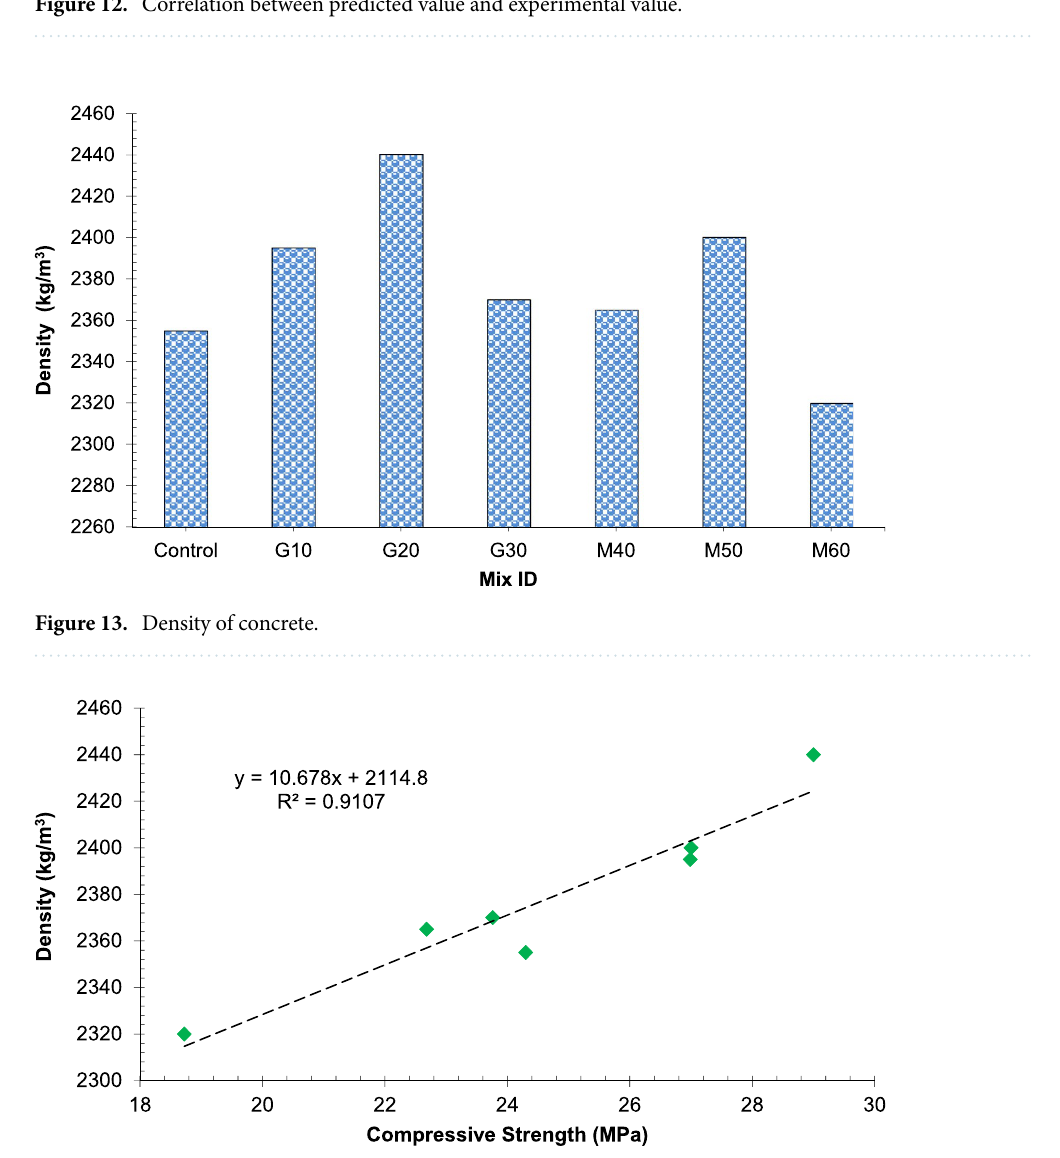
Figure 14. Correlation between density and compressive